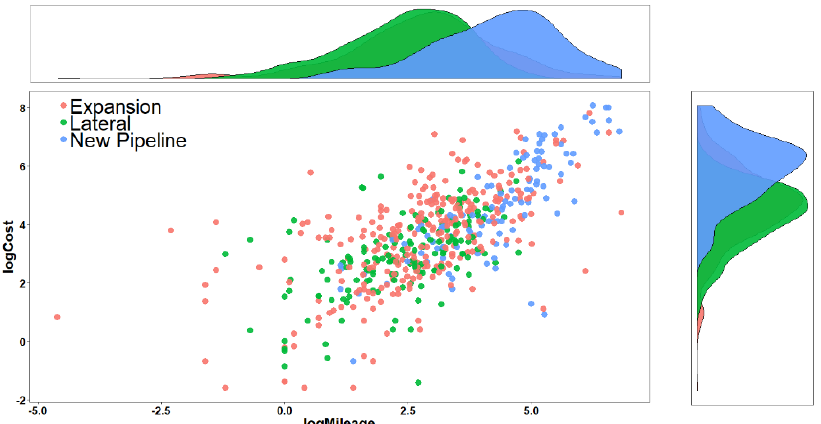
Figure 4. Scatter plot of Mileage (log-transformed) and Cost (log-transformed) across the categories of Project Type.